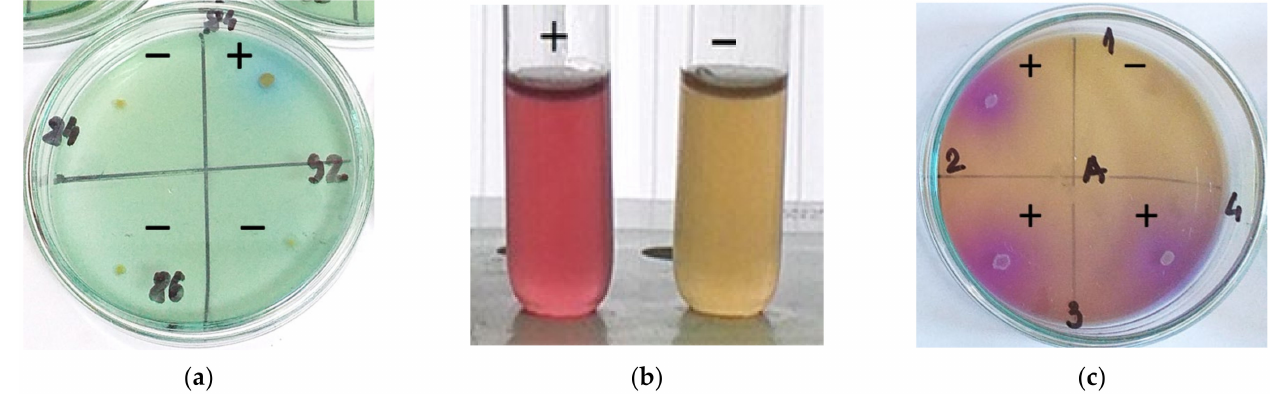
Figure 6. Physiological characterization of the tested lactic acid bacteria strains. ( a ) Use of citrate (the blue halo around the colonies indicates a positive reaction); ( b ) Acetoin production (Voges- Proskauer reaction; pink-red color indicates a positive reaction); ( c ) Amino acid-decarboxylase test (e.g., arginine; the purple halo around the colonies indicates a positive reaction); − and +, indicatespositive or negative reaction,